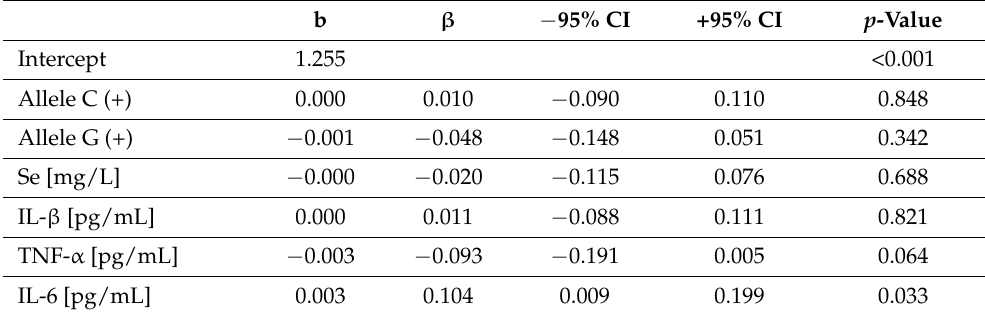
Table 10. Model without moderation.